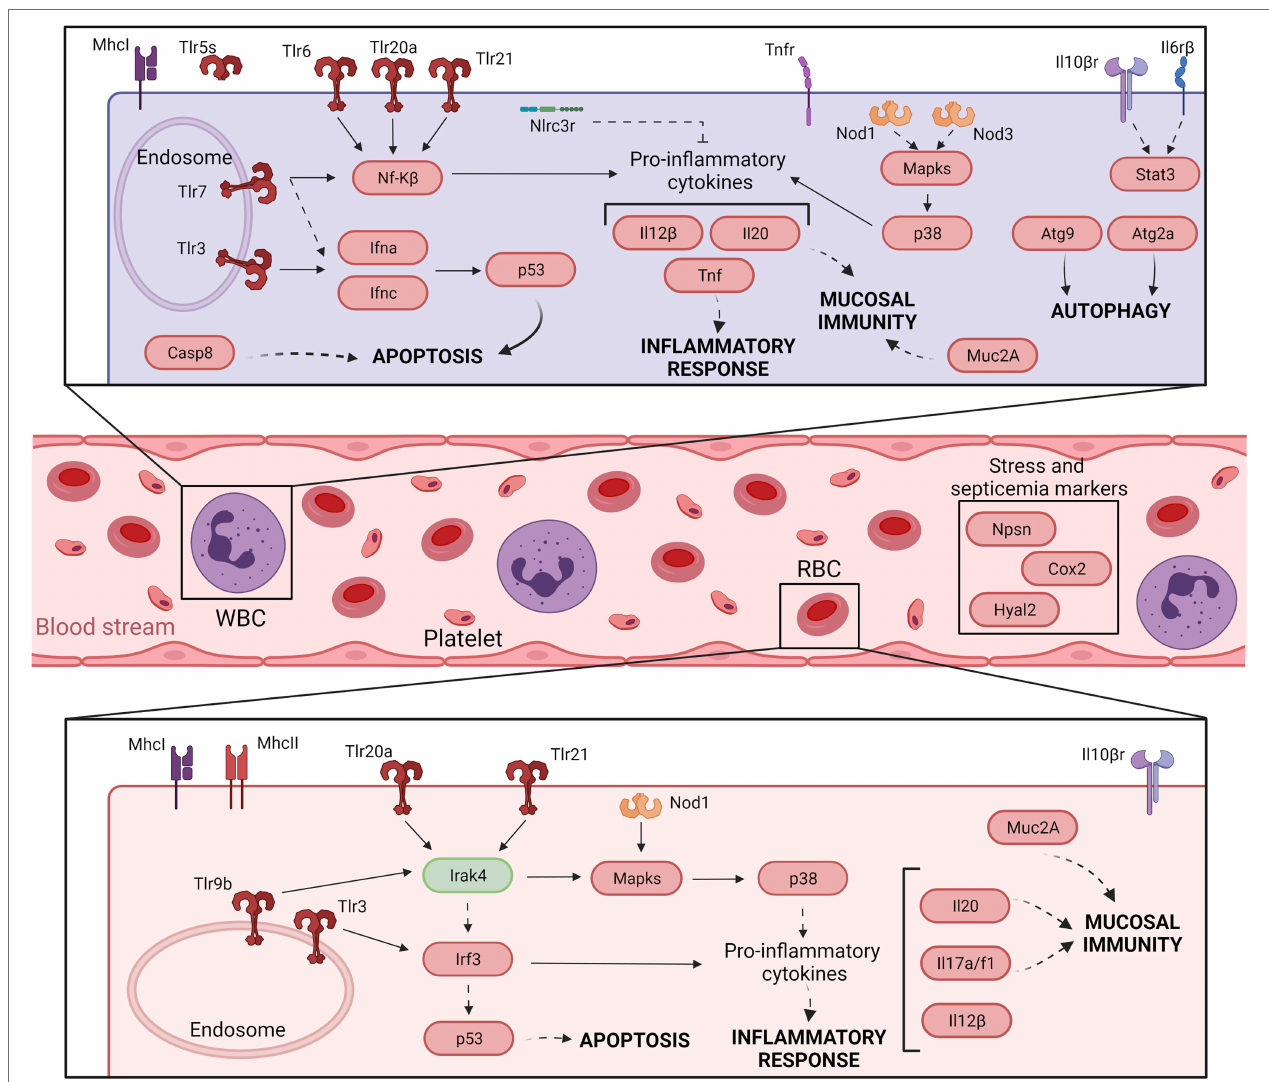
FIGURE 3 | Model of the immune response in eel blood against V. vulnificus infection: early phase of vibriosis (3 hpi). The model shows the resultant proteins produced by the main transcripts differentially expressed by eels’ blood cells during the early phase of Vv-vibriosis (at 3 hpi with V. vulnificus R99 strain) infection. The putative translated proteins from the major immune-related pathways are represented in a code color depending on the gene modulation: upregulated (red) and downregulated